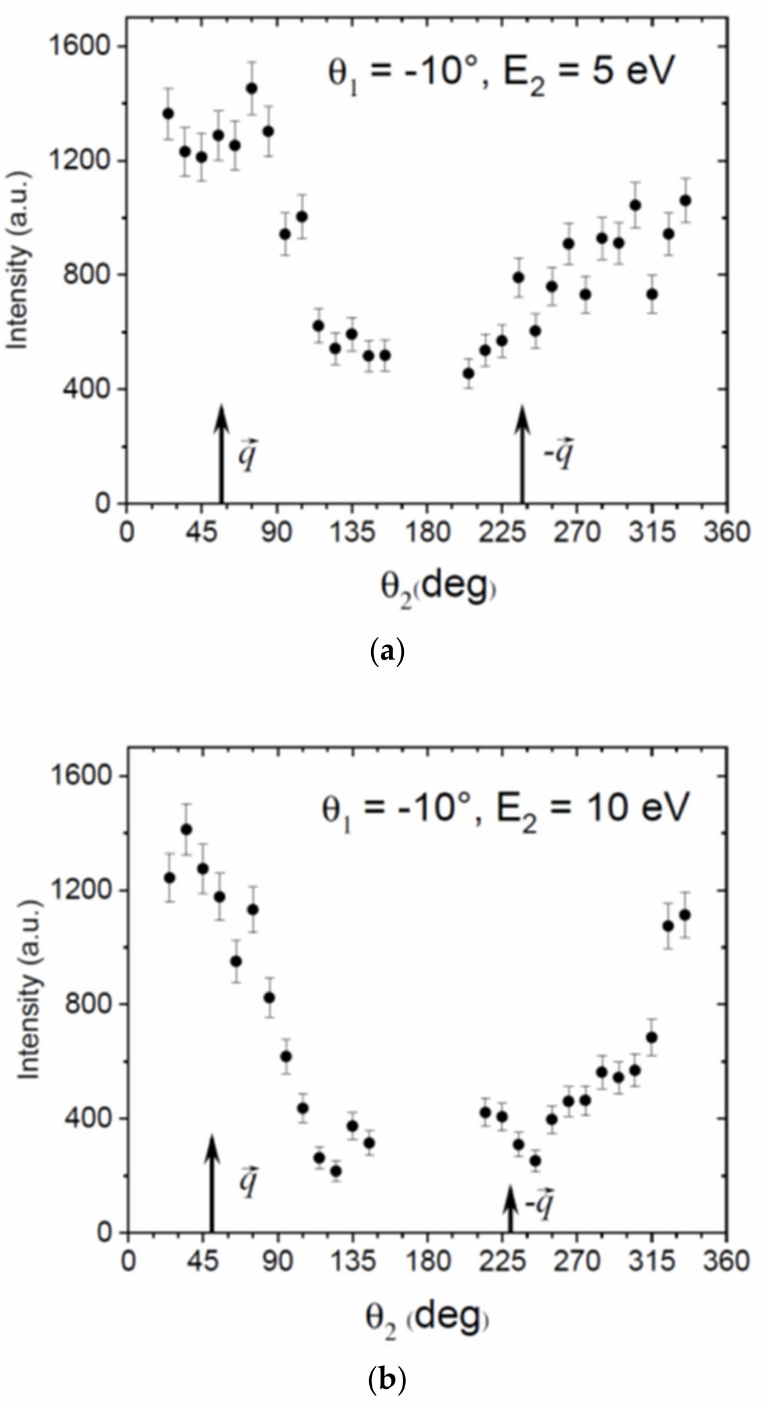
Figure 3. Experimental relative TDCS (in arbitrary units) for producing the parent ion of benzene (C 6 H 6 + ) at 90 eV electron impact energy as a function of the ejected electron emission angle θ 2 . The scattered projectile angle is fixed to θ 1 = − 10 ◦ while the ejected electron energy E 2 is chosen to be 5 eV ( a ) and 10 eV ( b ). The experimental results are for the scattering plane (xz). The angles of the → → q and its opposite − q are indicated by momentum transfer vector